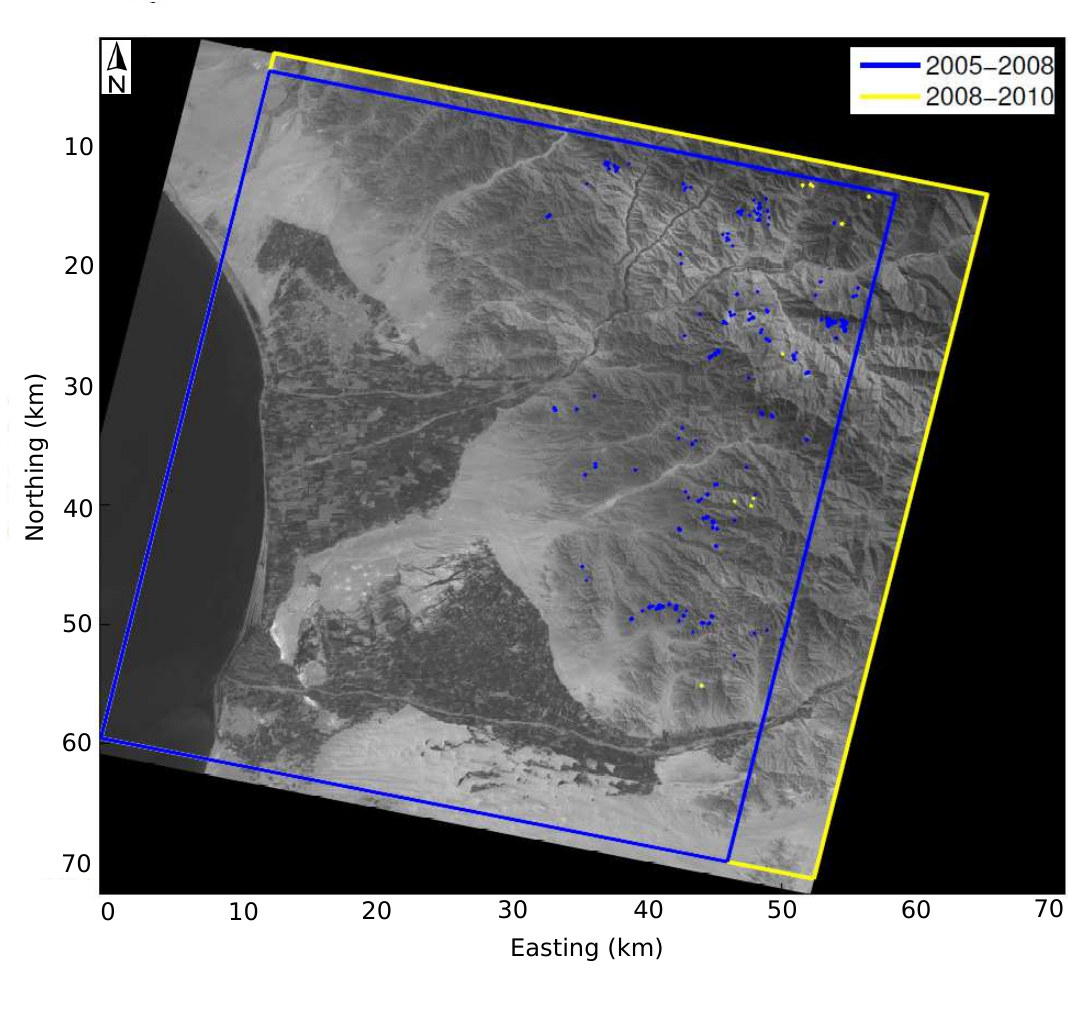
Figure 8. Multi-temporal inventories of the pairs #1. The 2005–2008 inventory is in blue and the 2008–2010 inventory is in